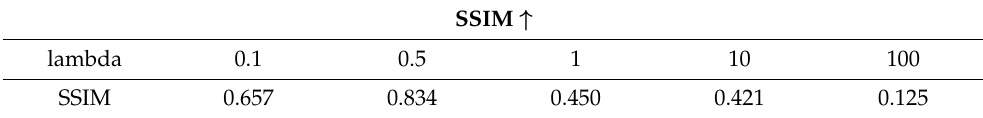
Table 1. Validation of hyper-parameter choices for λ in the self-supervised loss.